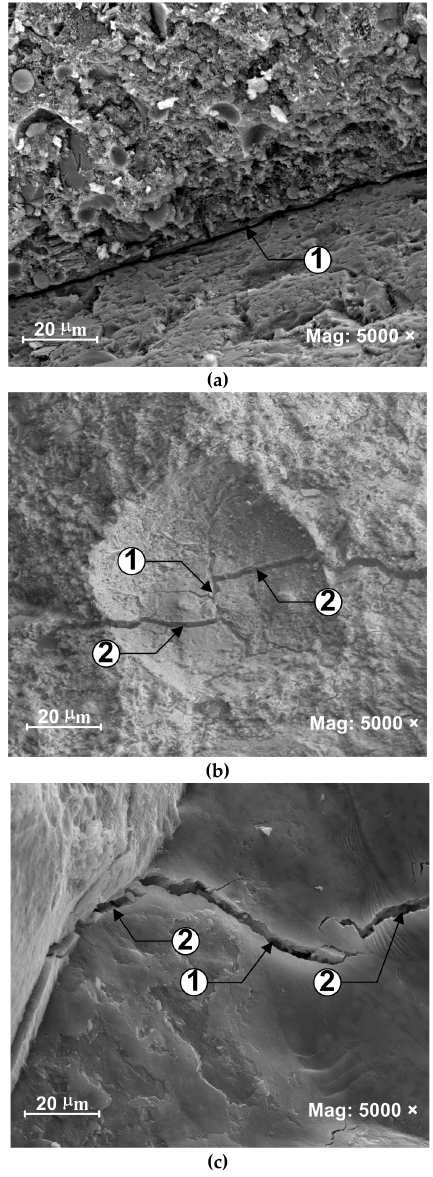
Figure 9. Microcracks occurring in concrete structures caused by stresses: ( a ) tensile stress, ( b ) shear stress, ( c ) torsion stress; 1—straight crack, 2—wing.